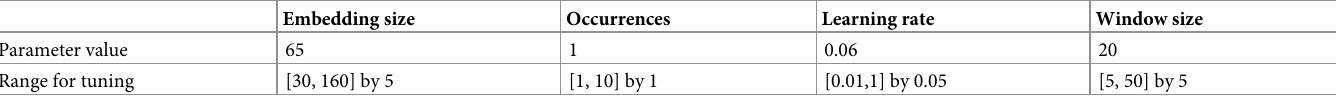
Table 4. Parameters used for our fastEmbed algorithm, and the range for hyper-parameter tuning using grid